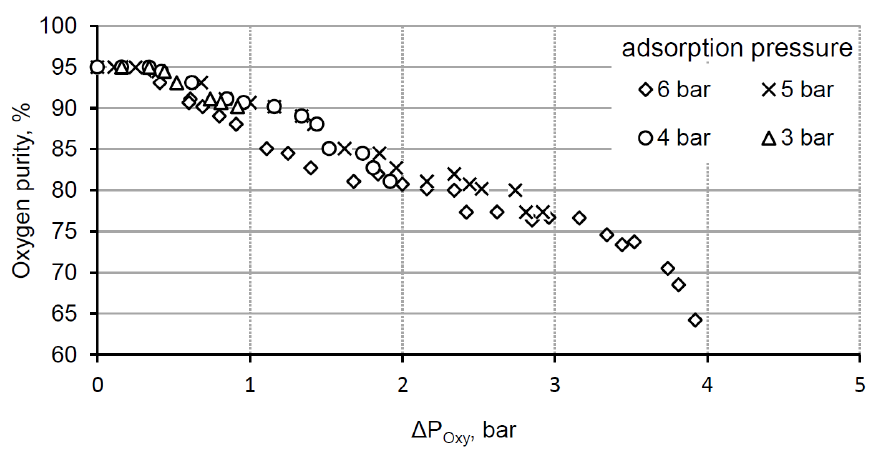
Figure 5. Dependence of the separated oxygen purity on the pressure difference between the adsorption pressure and the pressure in the oxygen